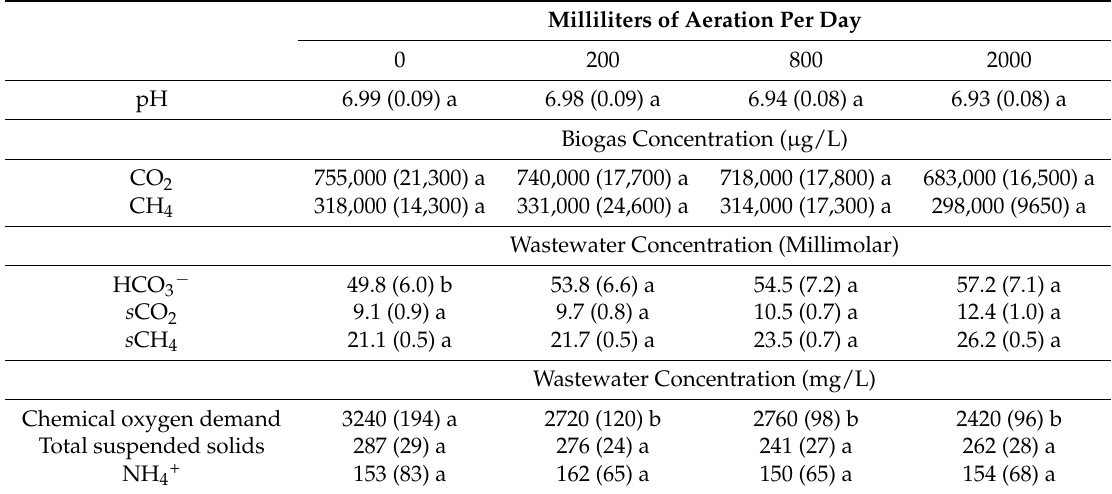
Table 1. Biogas and wastewater quality characteristics of digesters 1